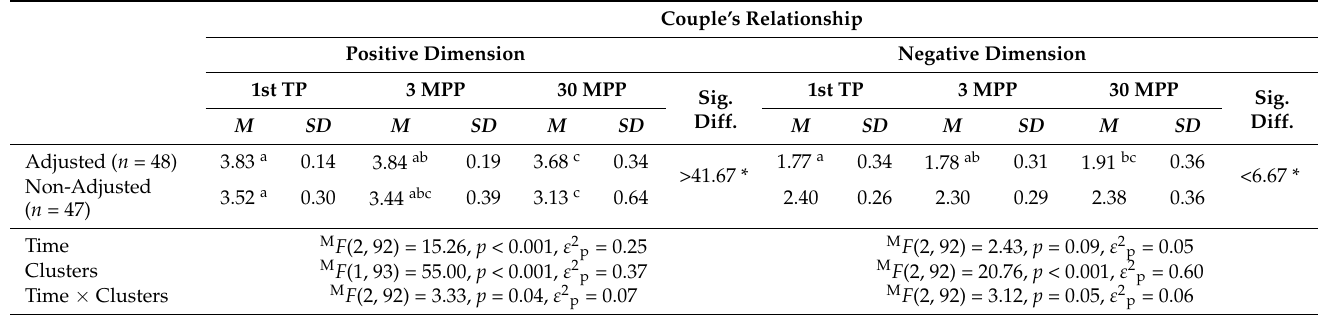
Table 4. Means and standard deviations for clusters’ validation.